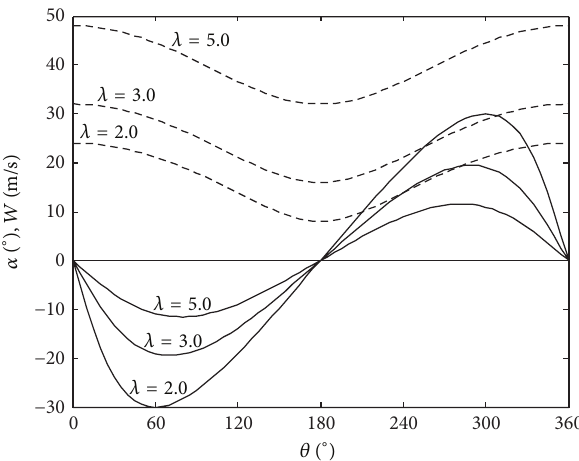
Figure 3: Incidence angle 𝛼 (solid lines) and relative velocity magnitude 𝑊 (dashedlines)duringaturbinerevolutionfordifferent tip speed ratios, with no blade pitch.